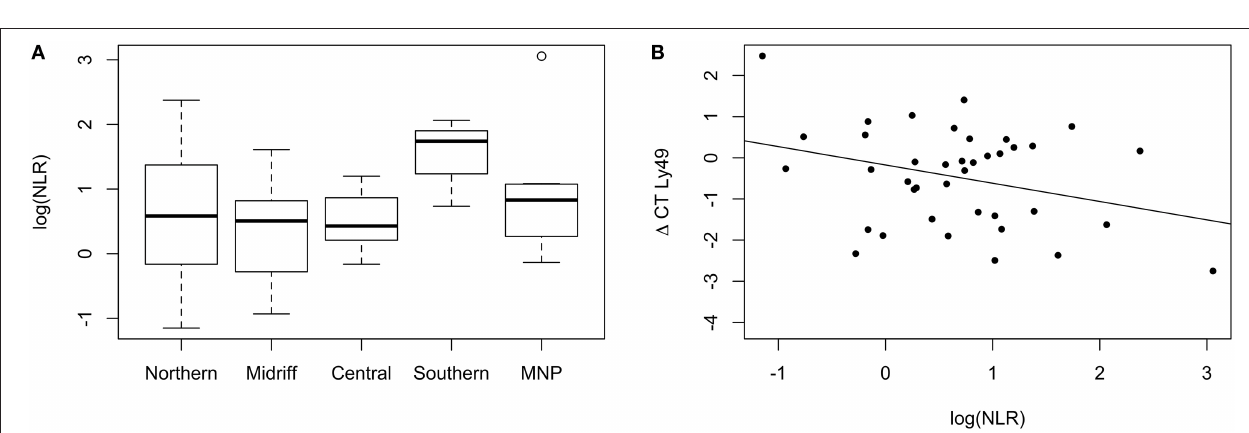
FIGURE 8 | (A) Neutrophil to Lymphocyte Ratio (NLR) of California sea lions from different regions. The variance of NLR was larger in sea lions from the northern and midriff regions. The plot shows the median (thick line), first and third quartile (box), and 95% confidence interval of the median (whiskers). MNP: Mexican North Pacific. (B) Relative transcription levels of Ly49 are explained by the NLR of California sea lions. Higher NLR values were associated with lower levels of transcription (Adjusted R 2 =